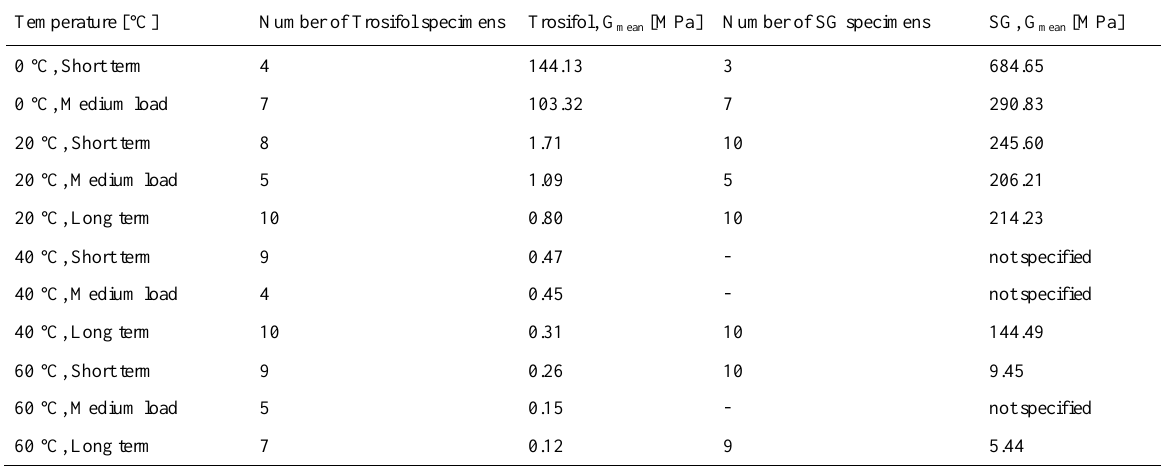
Table 1: Initial secant shear modules obtained from the experimental data for Trosifol and